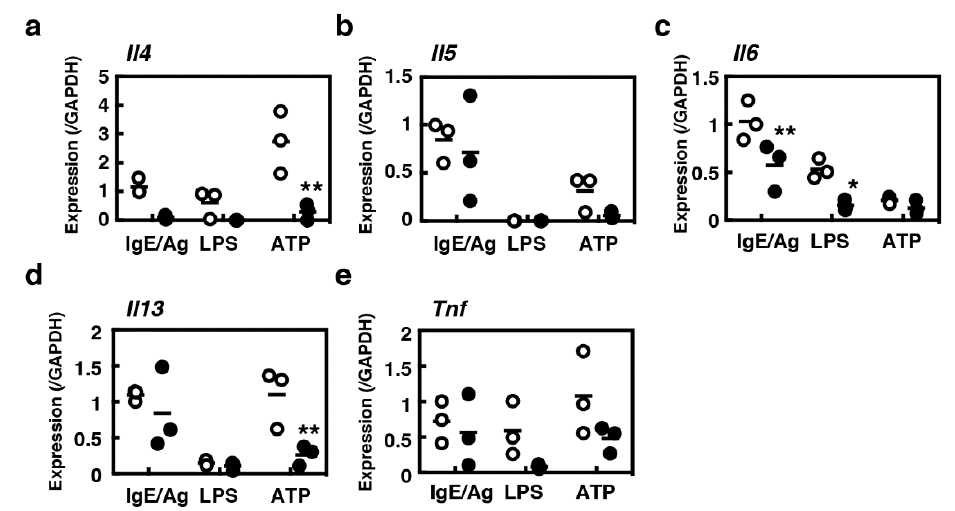
Figure 5. Comparison of transcriptional induction of various cytokines in between BMMCs and MCs / IL-9. BMMCs (open circles) or MCs / IL-9 (closed circles) were sensitized with 1 µ g / mL anti-TNP IgE (clone IgE-3) for 3 h at 37 ◦ C. The cells were twice washed and stimulated with the antigen (100 ng / mL, TNP-conjugated BSA) for 1 h (IgE / Ag). In parallel, BMMCs (open circles) or MCs / IL-9 (closed circles) were stimulated with LPS (1 µ g / mL) or ATP (1 mM) for 1 h at 37 ◦ C. Expression levels of mRNA of a series of cytokines (( a ), IL-4; ( b ), IL-5; ( c ), IL-6; ( d ), IL-13; ( e ), TNF- α ) were determined by quantitative RT-PCR. Statistical significance for comparison between BMMCs and MCs / IL-9 was determined by unpaired Student’s t -test. Values with * p < 0.05 and ** p < 0.01 are regarded as